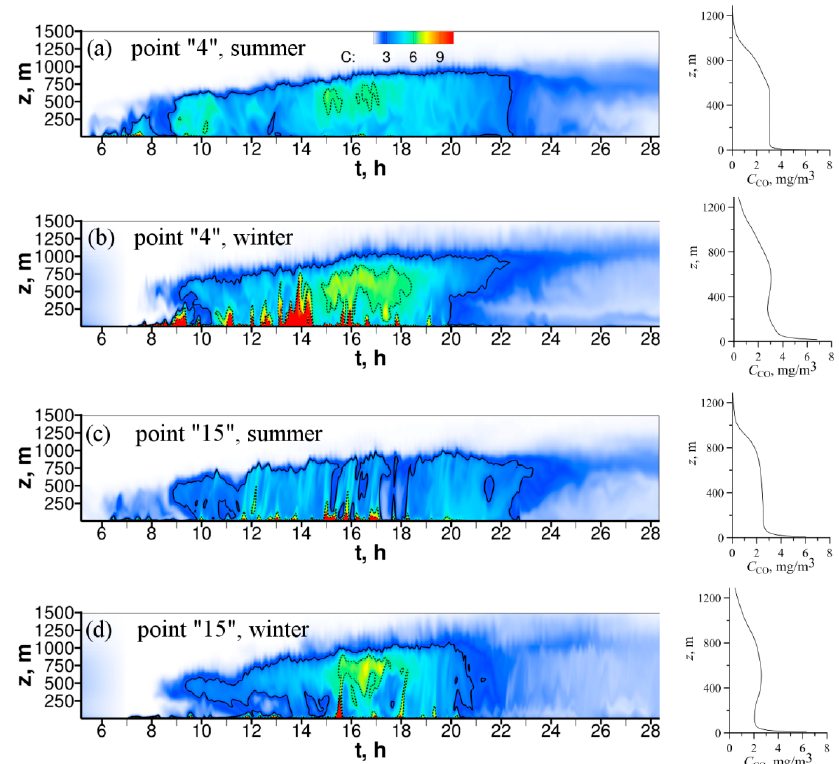
Figure 13. Temporal evolution of CO concentration fields (left) and daily-averaged concentration profiles (right) for several points (shown in Figure 1). ( a , c ) Summer case; ( b,d ) Winter case.